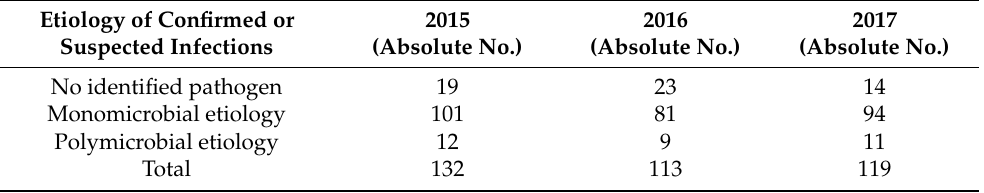
Table 3. Identification of etiologic agents causing/suspected of causing neonatal